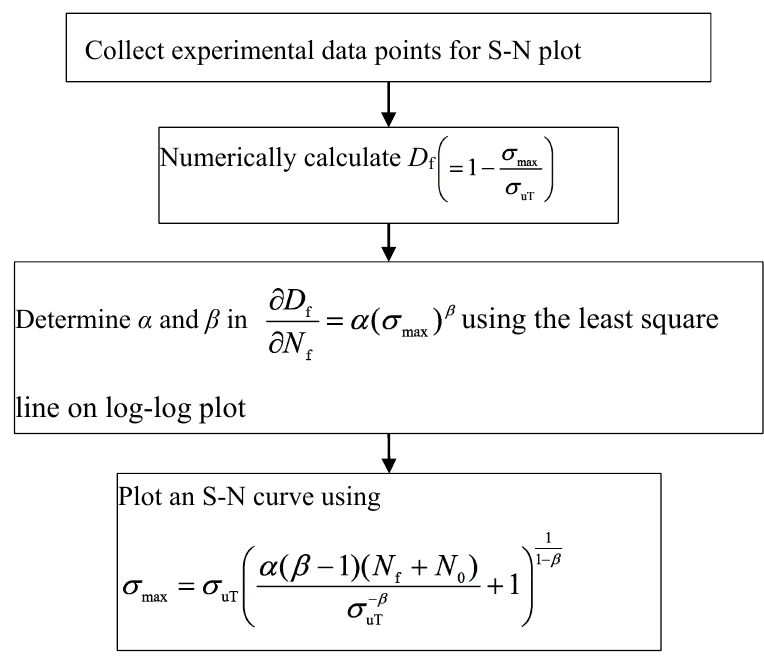
Figure 2. Sequence for plotting an S-N curve using the Kim and Zhang model.